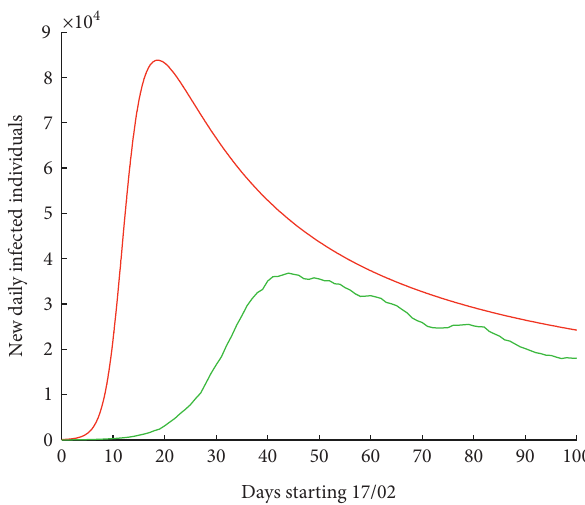
Figure 7: Number of new daily infected individuals in Europe, starting 17 February 2020, for 100 days. Real data are shown in green colour, while the result of the numerical simulations of the hypothetic curve with 56% more of infectivity is shown in red colour.